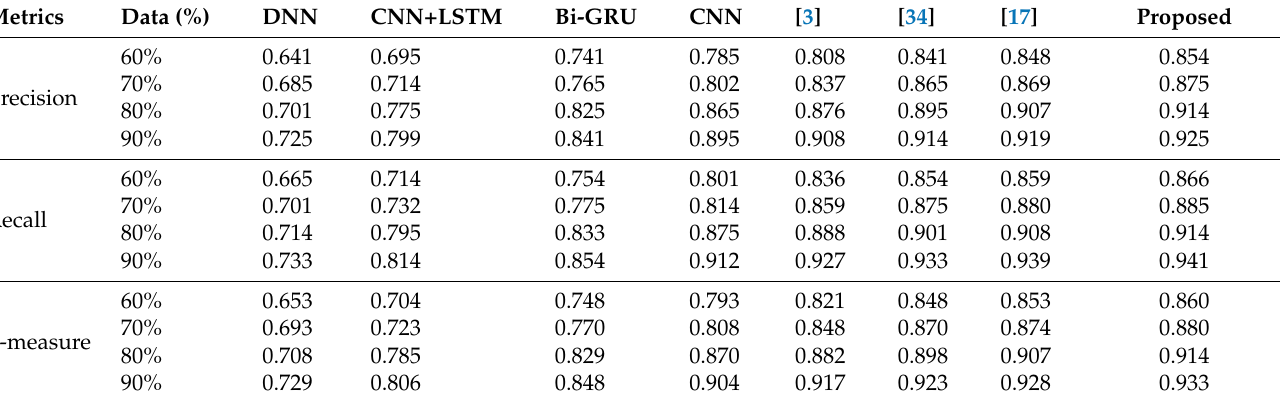
Table 7. Comparative analysis of Review Rating Prediction for Yelp 2014 dataset in terms of precision, recall and